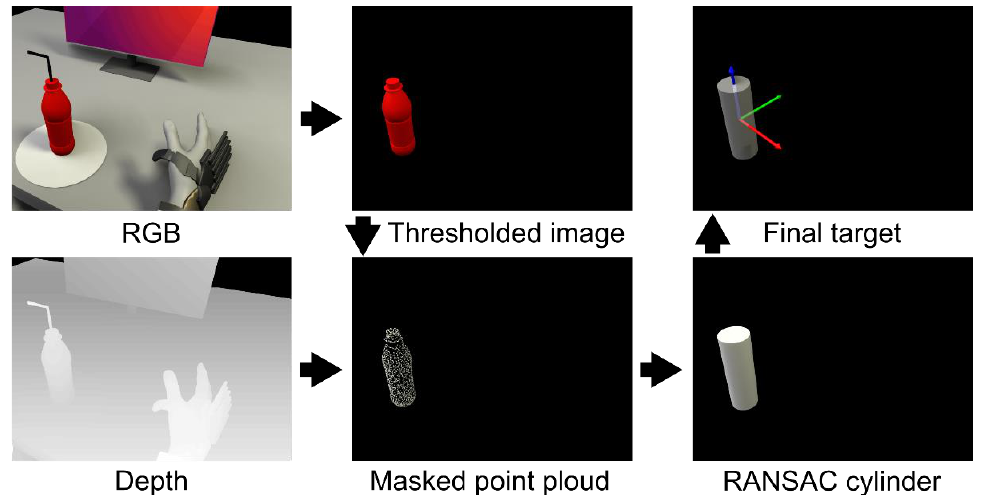
Figure 7. Image processing pipeline. A threshold is applied to the RGB image ( top left ), which results in a mask of all the red objects in the image (in this case the bottle, top middle ). This mask is used to isolate the same objects in the point cloud ( bottom middle ), which is obtained from the depth image ( bottom left ). A random sample consensus method is performed to find the best fitting cylinder shape on the extracted point cloud object(s) ( bottom right ). The center of the found cylinder(s) is determined to be the target position ( top right ).